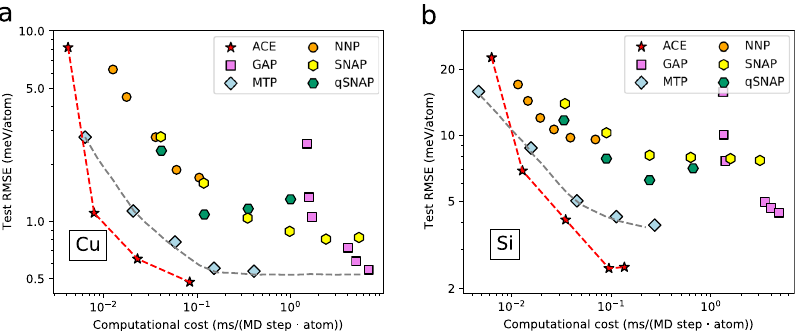
Fig. 1 ACE Pareto front. Test RMSE vs. computational cost for Cu ( a ) and Si ( b ) for ACE potentials compared to a recent benchmark study 15 . The timings from Zuo et al. 15 were reduced by constant factors 0.55 (Cu) and 0.60 (Si) to correct for hardware differences and the ACE timings then